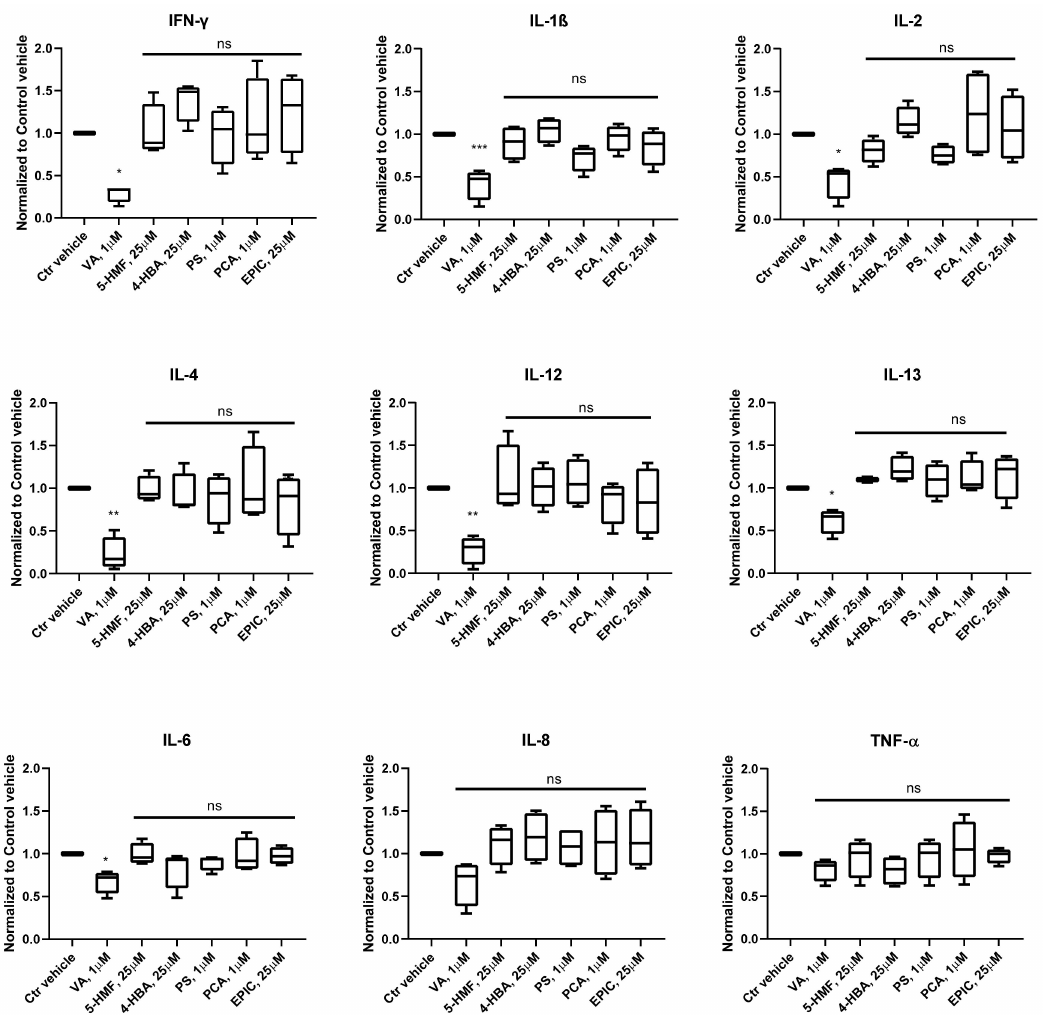
Figure 2. Expression profile of pro-inflammatory cytokines after treatment with Vanillic acid (VA), 5-Hydroxymethylfurfural (5-HMF), 4-Hydroxybenzoic acid (4-HBA), Psoralidin (PS), Protocatechuicaldehyde (PCA), and Epimedin C (Epi C) versus control vehicle (Ctr vehicle) group in the conditioned medium of osteoarthritic chondrocytes microtissues. The cytokines interferon gamma (INF γ ), interleukin 1 β (IL-1 β ), IL-2, IL-4, IL-12, IL-13, IL-6, IL-8, and tumor necrosis factor α (TNF- α ) in phase III were measured using multiplex immunoassay. n = 4; n indicates the number of human OA chondrocytes donors; for each donor, three experimental replicates were analyzed. For the statistical analysis using Graphpad Prism, one-way analysis of variance (ANOVA) followed by Dunnett’s post hoc test (multiple comparisons) was applied. * p < 0.01, ** p < 0.001, *** p < 0.0005 vs. Ctr